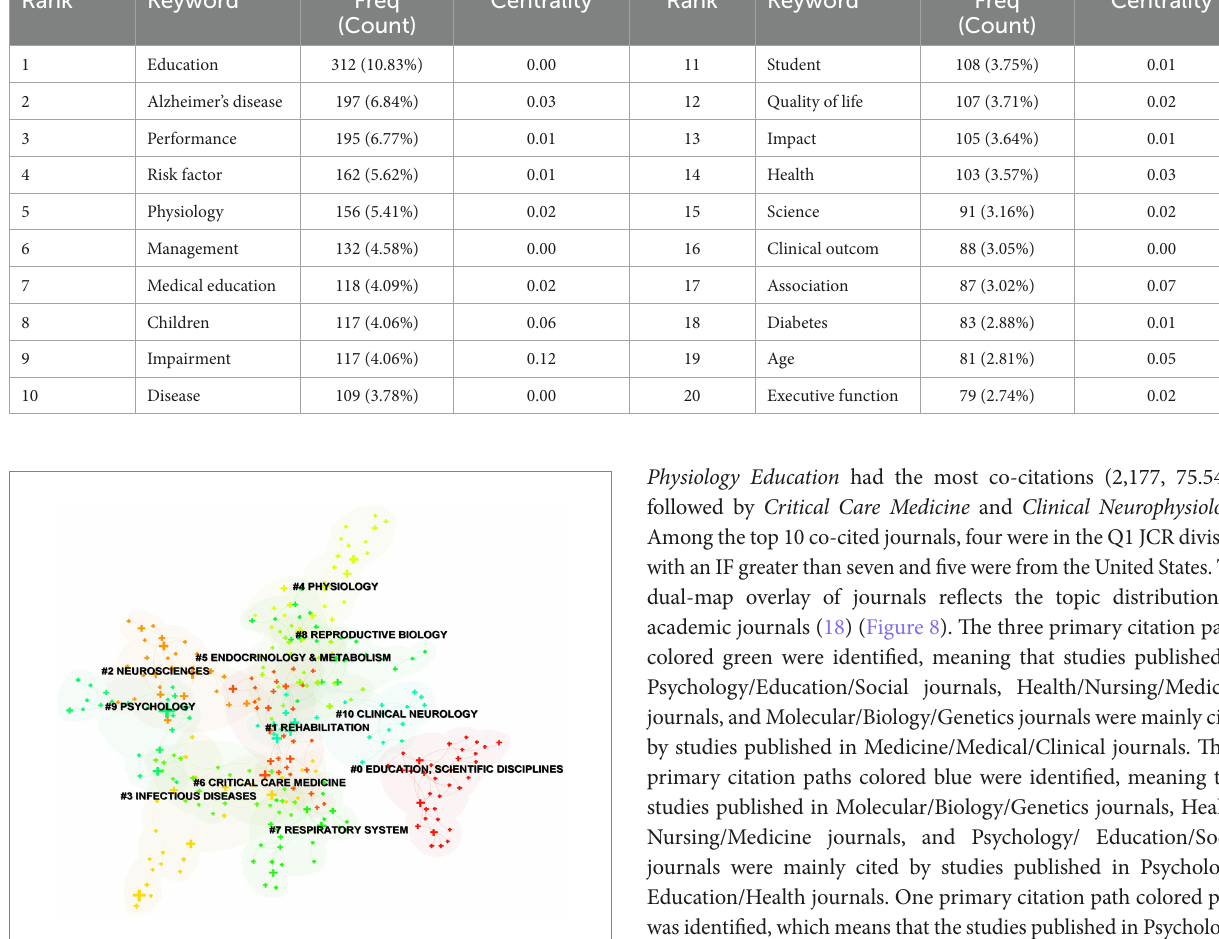
TABLE 4 Top 20 keywords of physiology teaching reform research in terms of frequency and centrality. Rank